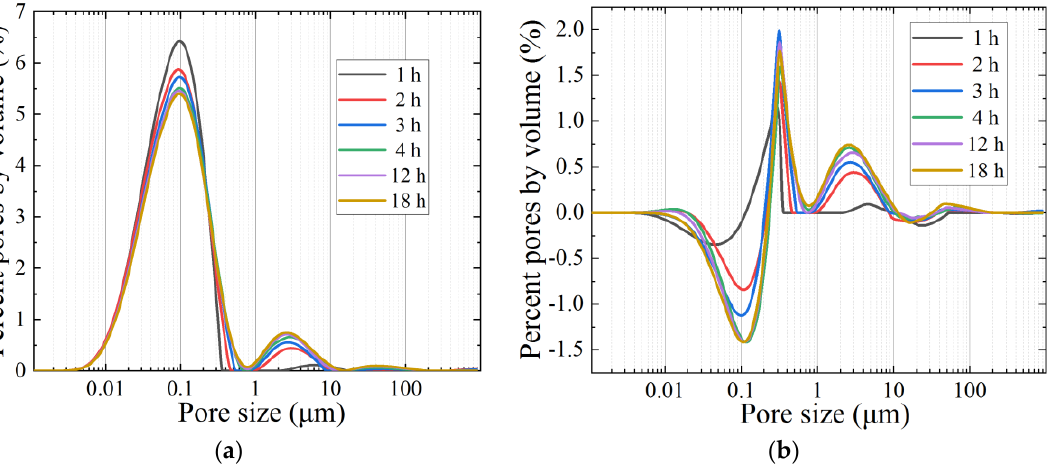
Figure 5. Effect of freezing duration: ( a ) pore size distribution; ( b ) differences in the pore size